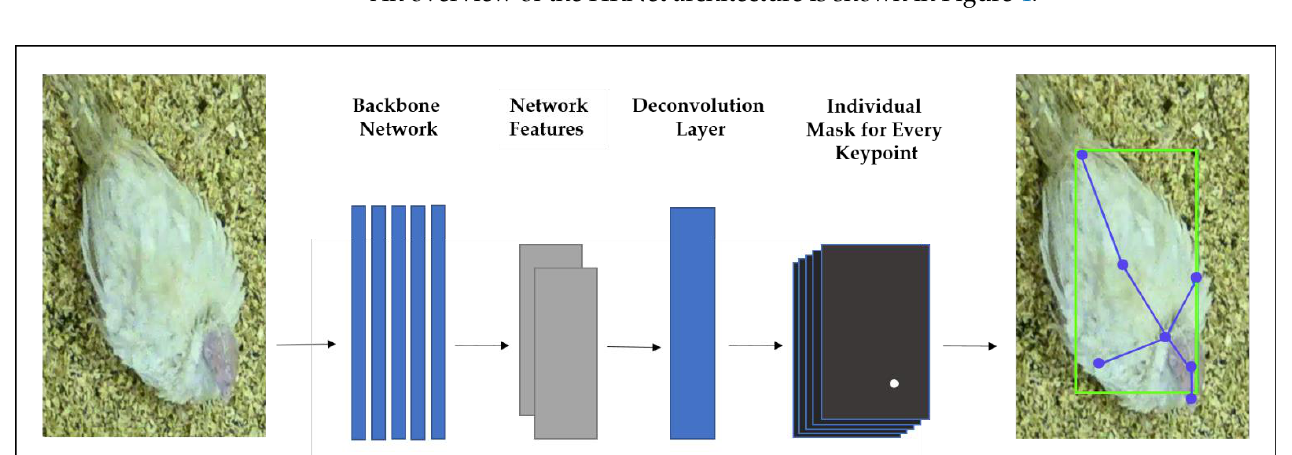
Figure 4. Overview of the baseline keypoint detection method by Xiao et al. [45].